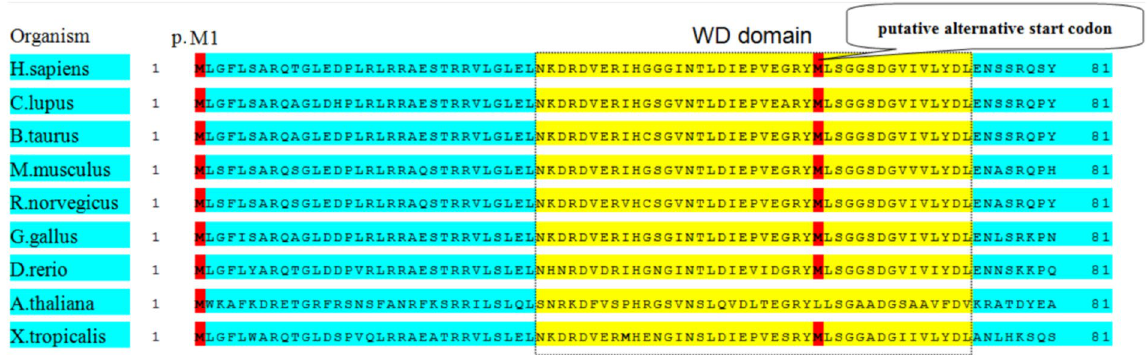
Figure 5. Multiple species alignment of ERCC8 orthologues shows the high evolutionary conservation of the p. M1 sequence context in vertebrates. The mutation of c.2 T > A possibly makes the translation of polypeptide chain lose the start code and result in the putative alternative start